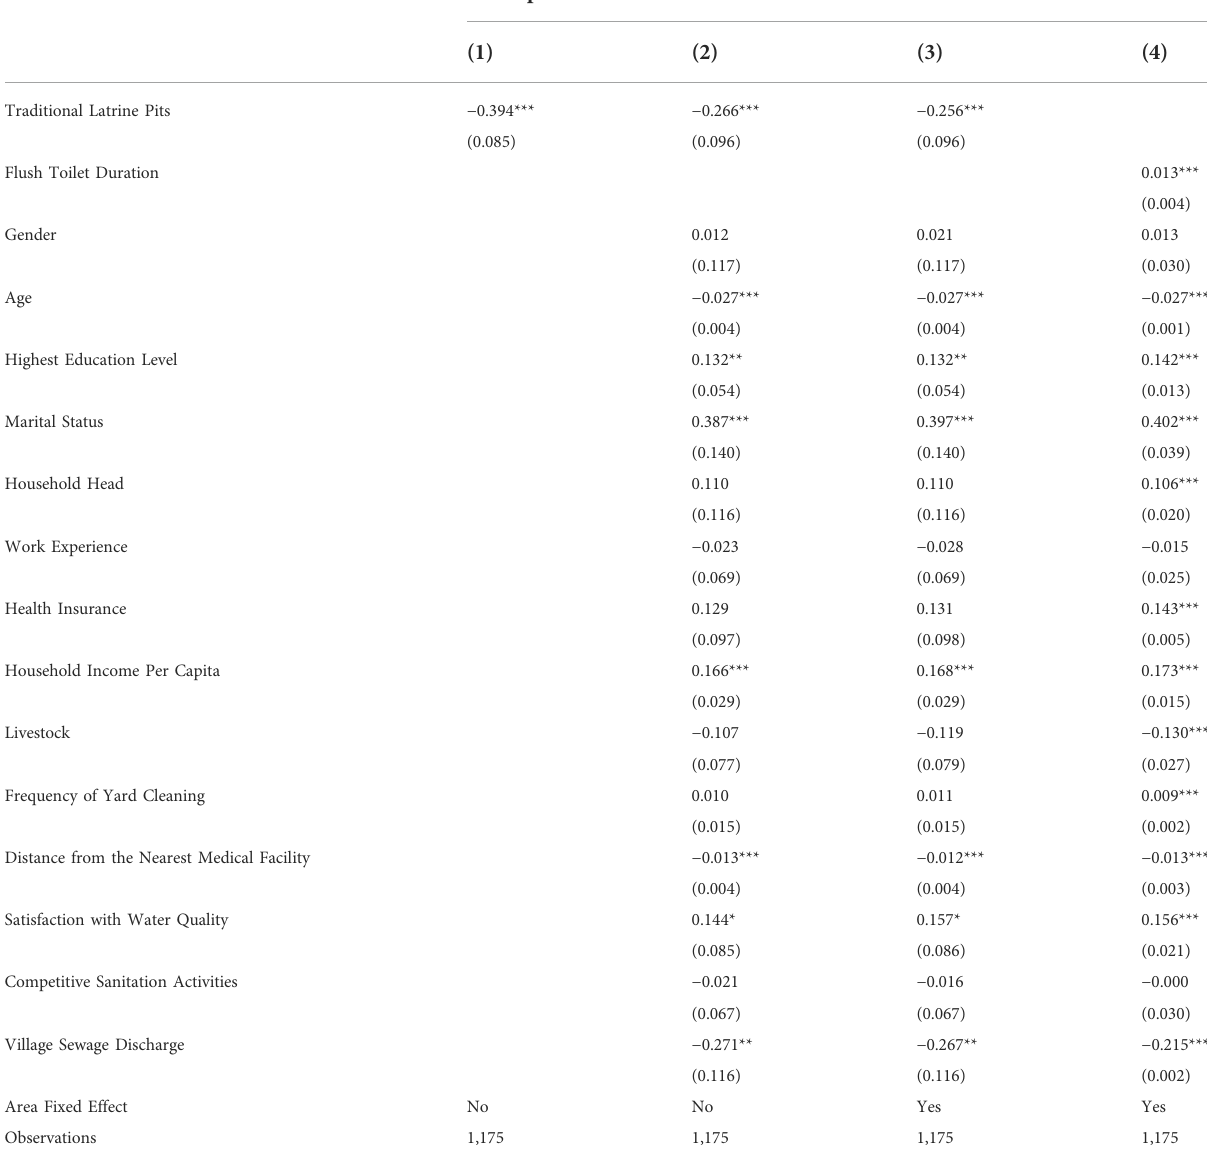
TABLE 2 Baseline regression